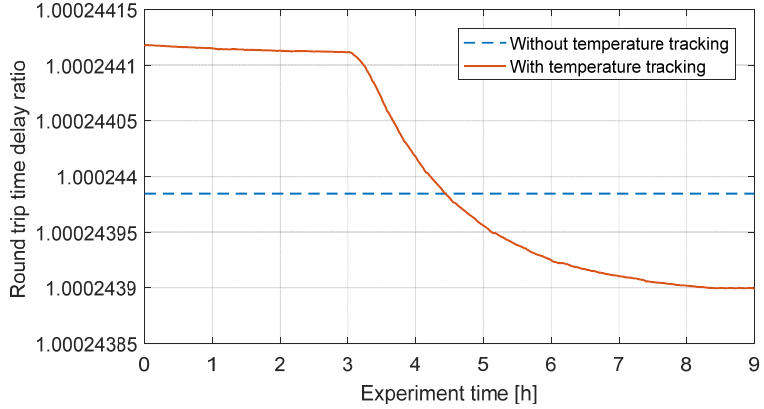
Figure 8. Curves of two round trip ratios.